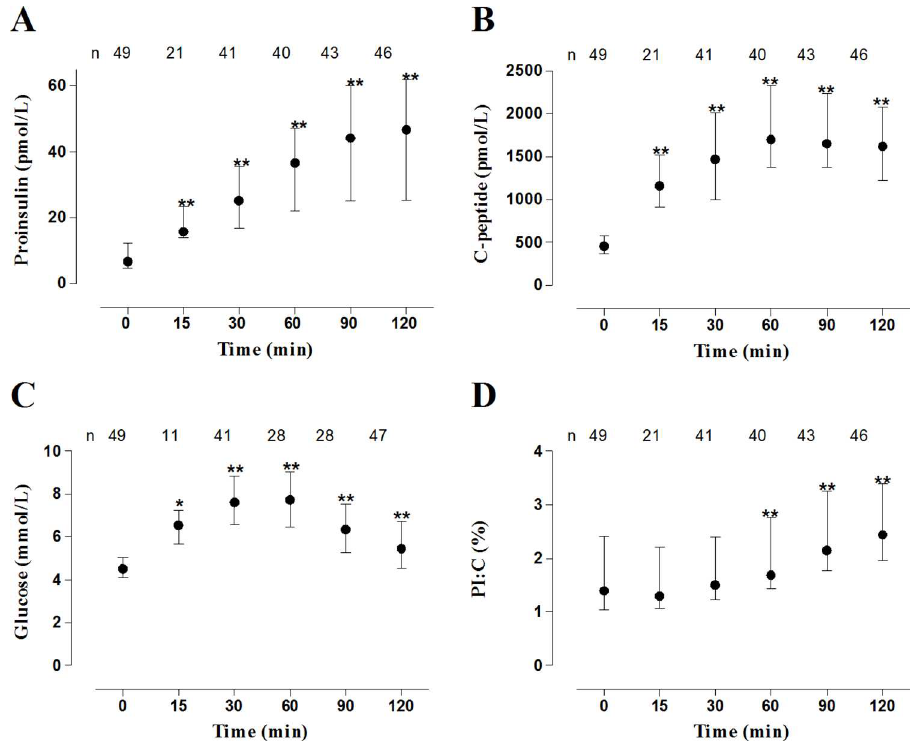
Fig 1. Evolution of proinsulin(A), C-peptide(B), glucose(C) and PI:C ratio (D) duringOGTT in relatives at high autoantibody-inferred risk; * P = 0.003; ** P < 0.001. The number of available samples tested is indicated aboveeach time